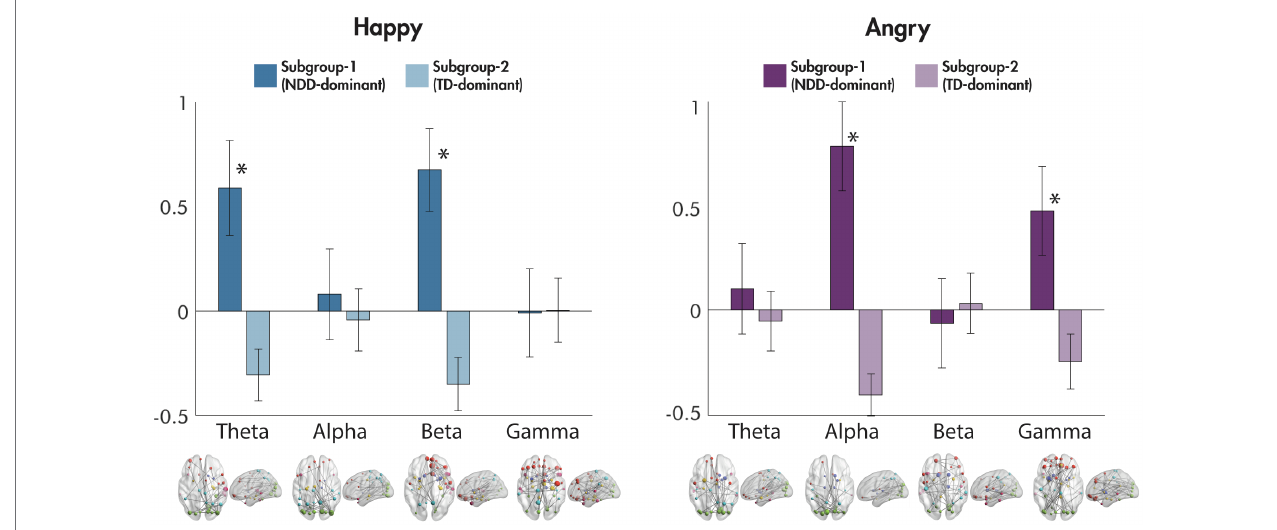
FIGURE 4 | Differences between subgroups in mean network connectivity strength for happy and for angry faces compared to baseline. The mean network connectivity strength for each significant network to happy and angry faces compared to baseline for each frequency band is plotted for each of the subgroups in the bar graphs (error bars represent standard deviation). Significant networks are plotted in the glass brains under each corresponding frequency range. * p <